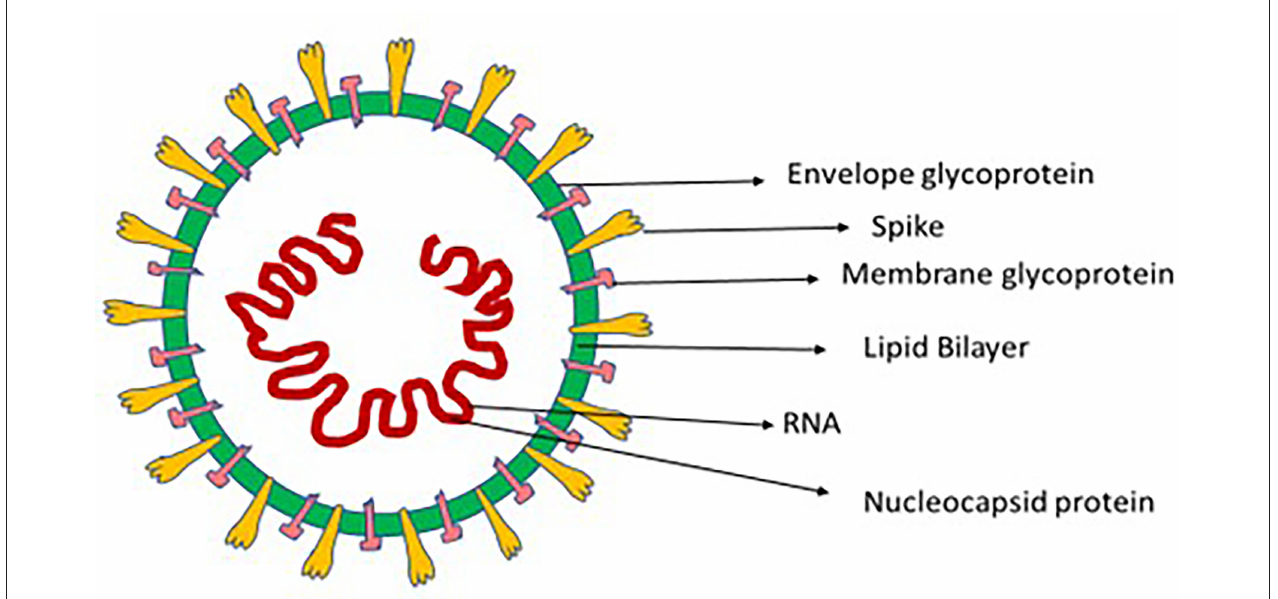
FIGURE 1 | Composition of coronavirus instigating respiratory disease in human beings.